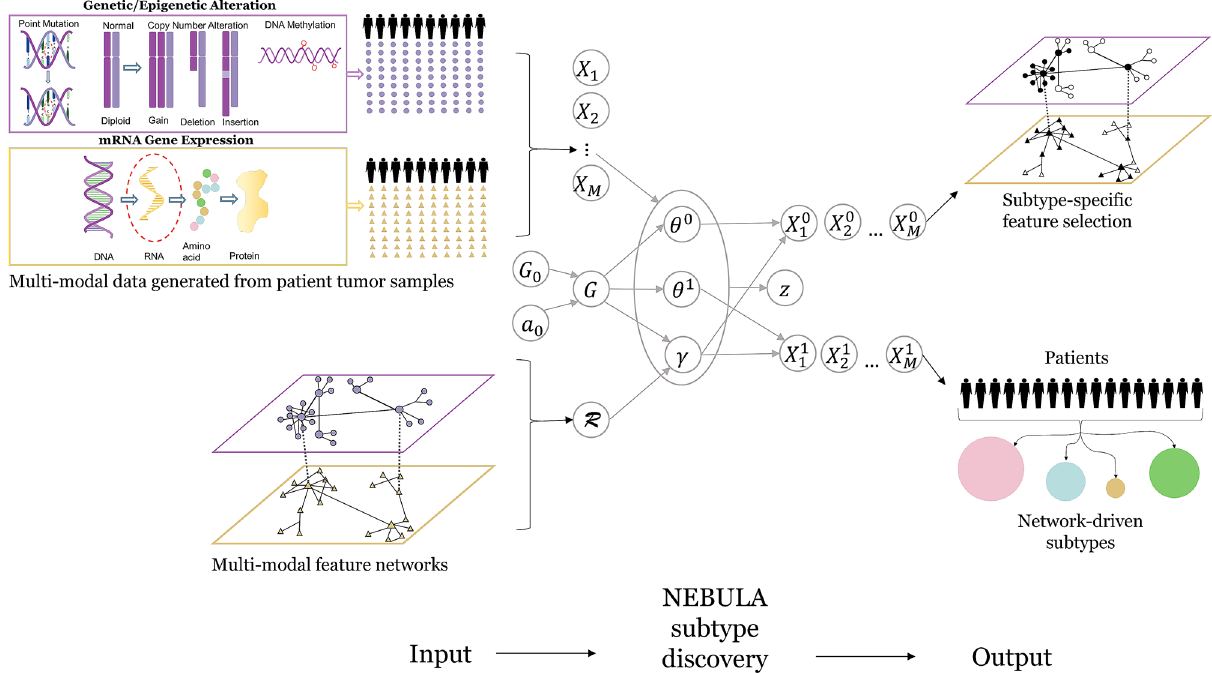
Figure 1. Nebula, a multimodal integrative clustering framework using a Bayesian nonparametric Dirichlet process mixture (DPM) model for simultaneous high-dimensional clustering and feature selection, with biological networks within and between data modalities incorporated as prior knowledge via graph